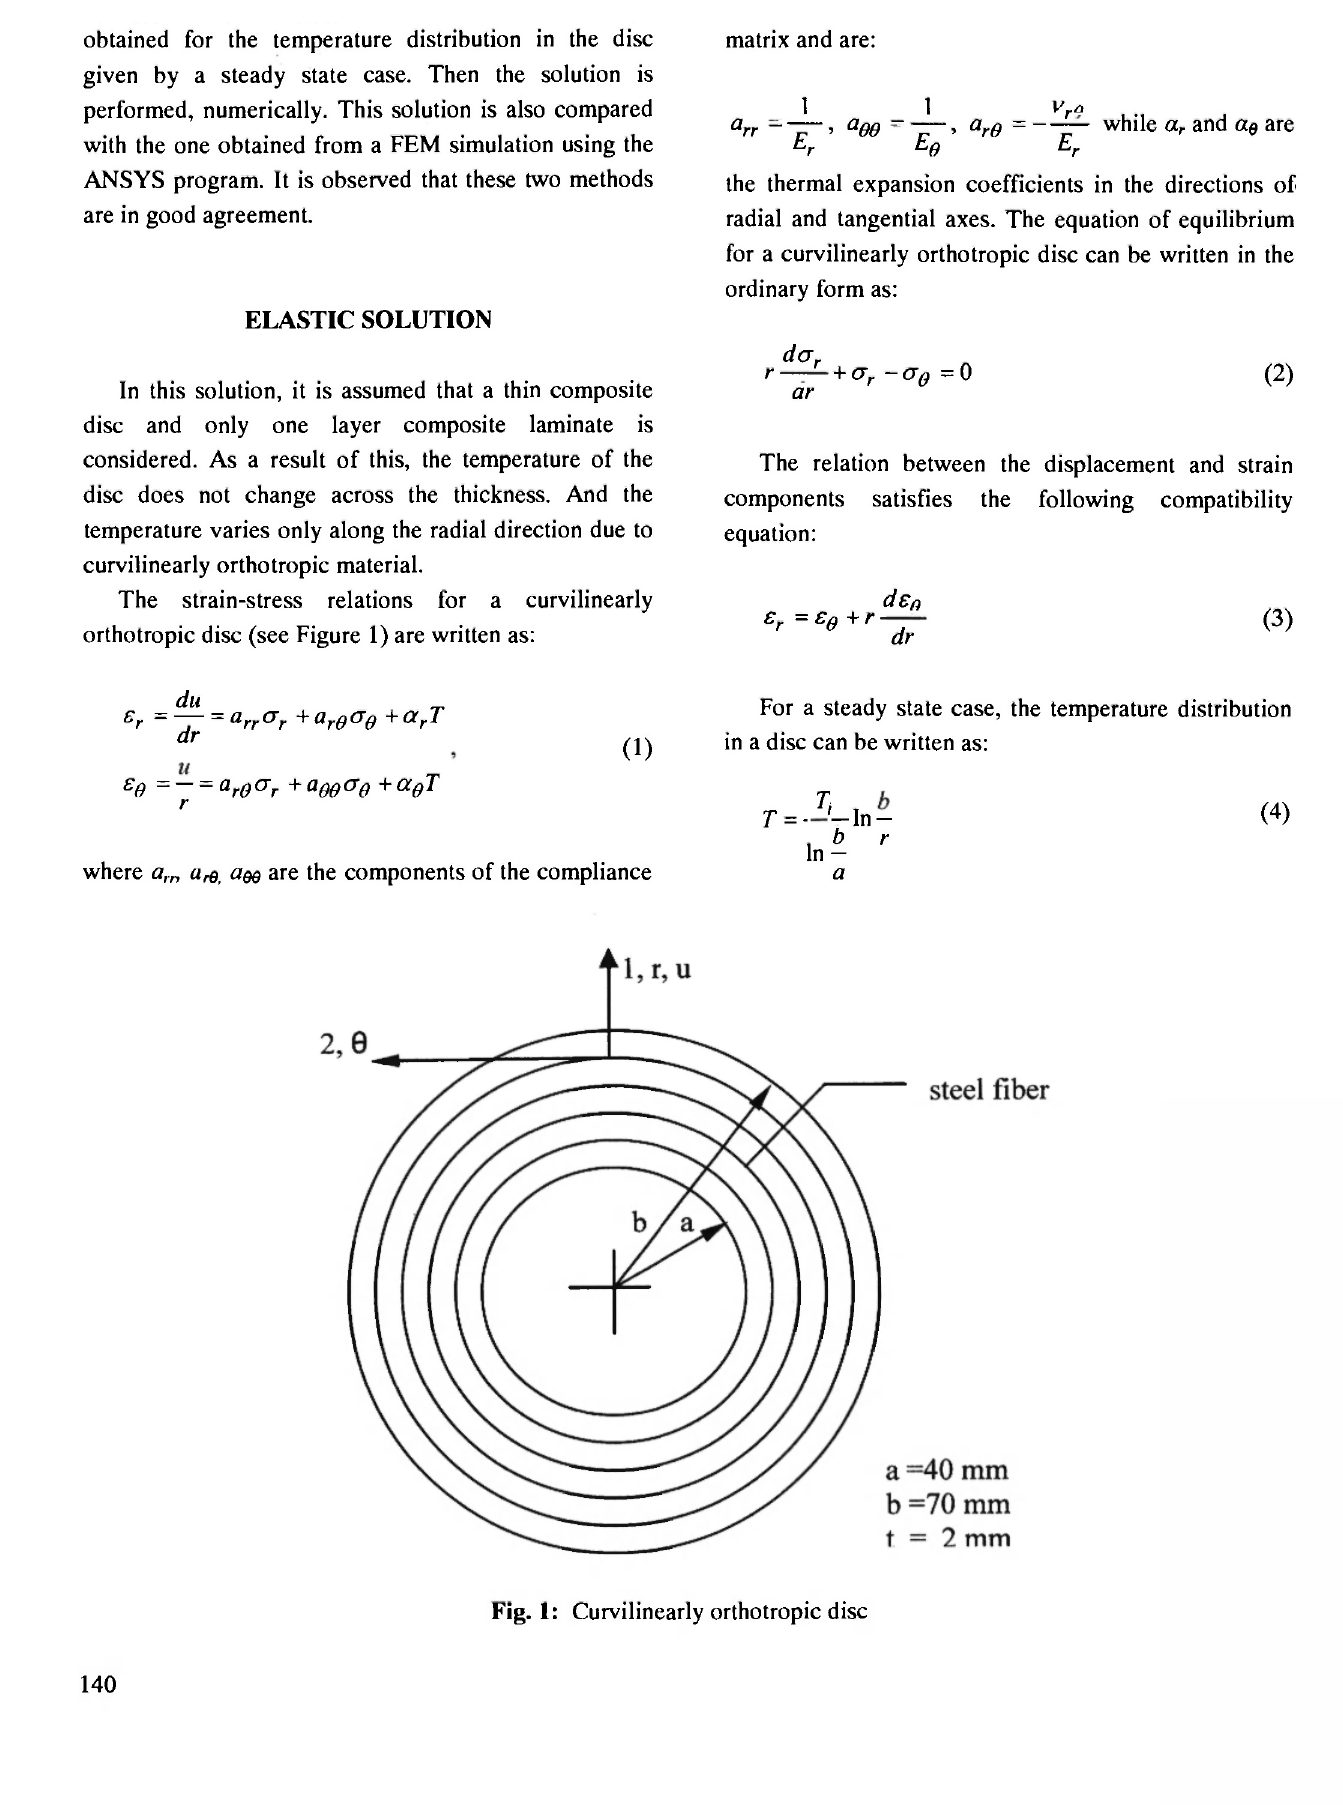
Fig. 1: Curvilinearly orthotropic